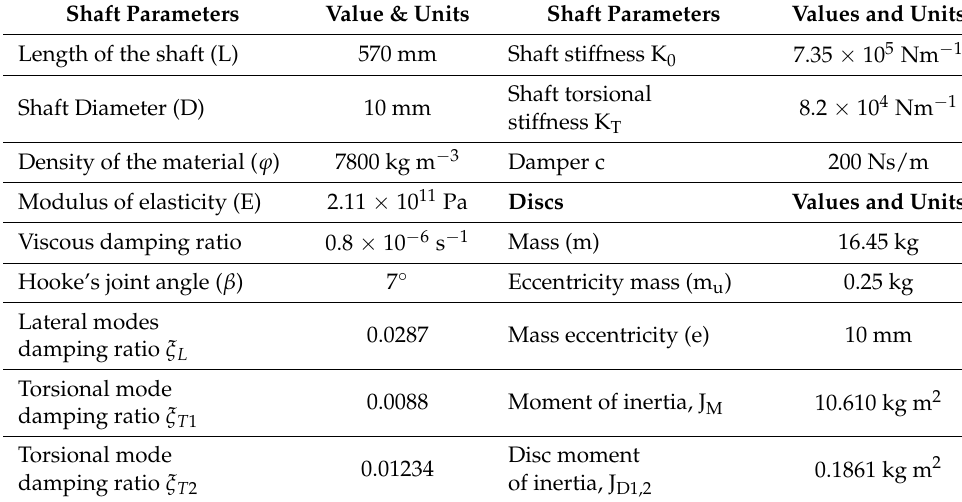
Table 1. Rotor system R-K 4